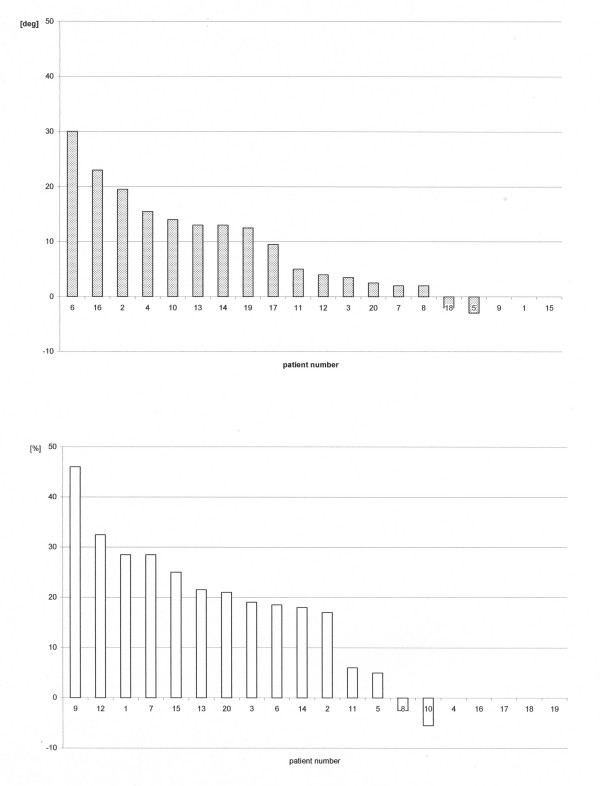
Ranking of changes due to treatment. Upper graph: changes in visual field size (kinetic perimetry). Lower graph: changes in detection rate (static perimetry)